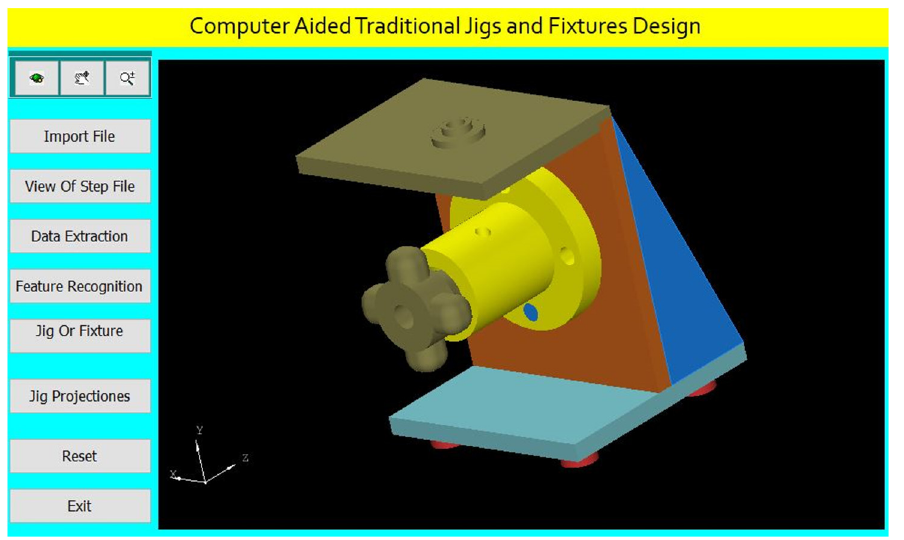
Figure 27. Computer-aided design of a jig for the cylindrical part.